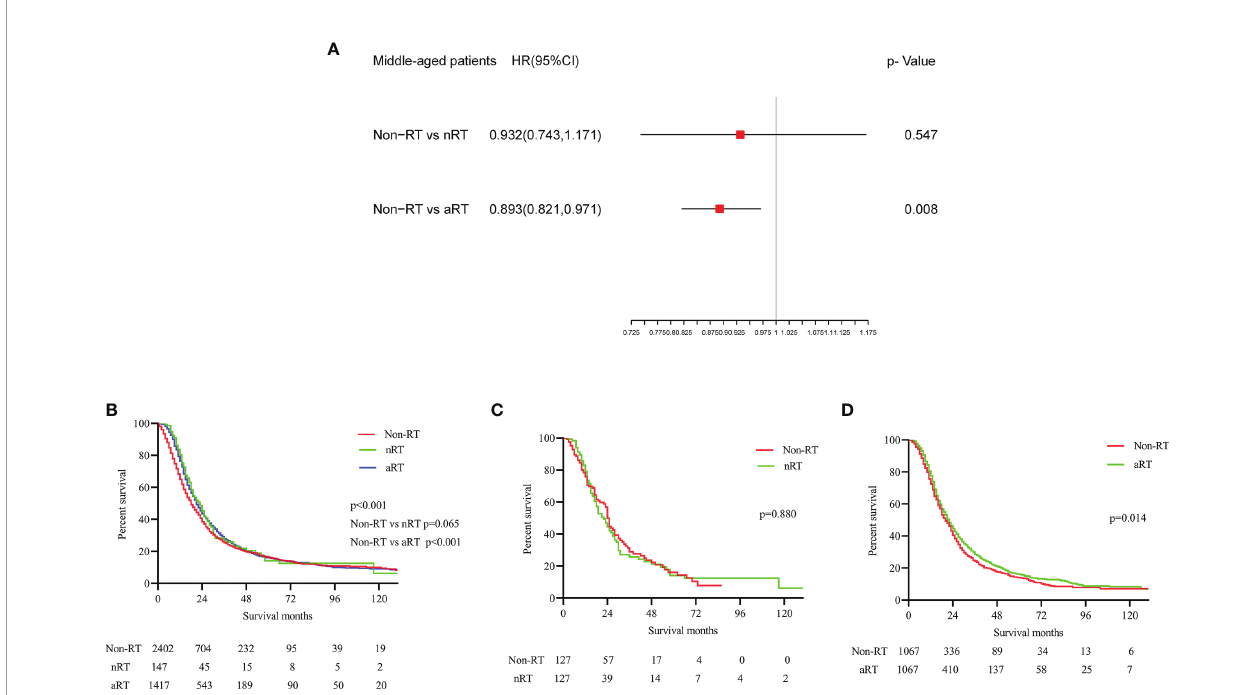
FIGURE 3 | The forest plot and the survival curves were used to demonstrate the effect of radiotherapy in middle-aged stage IIB/III PDAC patients. (A) . The forest plot for non-RT vs. nRT and non-RT vs. aRT in middle-aged stage IIB/III PDAC patients; (B) . The survival curve for total middle-aged stage IIB/III PDAC patients before PSM; (C) . The survival curve for non-RT vs. nRT in middle-aged stage IIB/III PDAC patients after PSM; (D) . The survival curve for non-RT vs. aRT in middle- aged stage IIB/III PDAC patients after